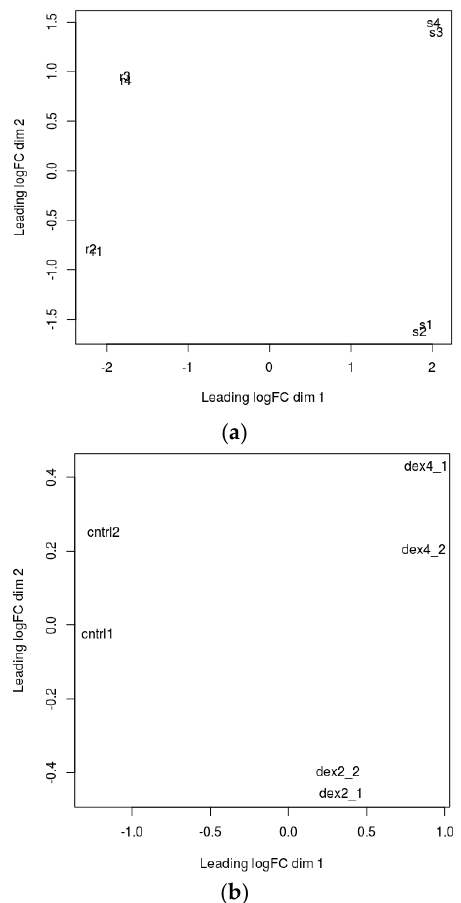
Figure 1. Multidimensional scaling plots ( a ) for JQ1 treatment; ( b ) for Dexamethasone treatment. s1—JQ1 sensitive-3 h treatment, s2—JQ1 sensitive-3 h treatment, s3—JQ1 sensitive-24 h treatment, s4—JQ1 sensitive-24 h treatment, r1—JQ1 resistant-3 h treatment, r2—JQ1 resistant-3 h treatment, r3—JQ1 resistant-24 h treatment, r4—JQ1 resistant-24 h treatment, ctrl1—control 1, ctrl2—control 2,